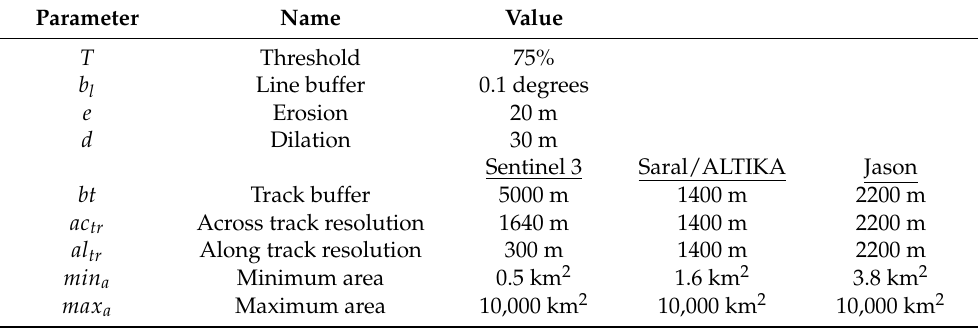
Table A1. Parameters for the virtual station extractor.